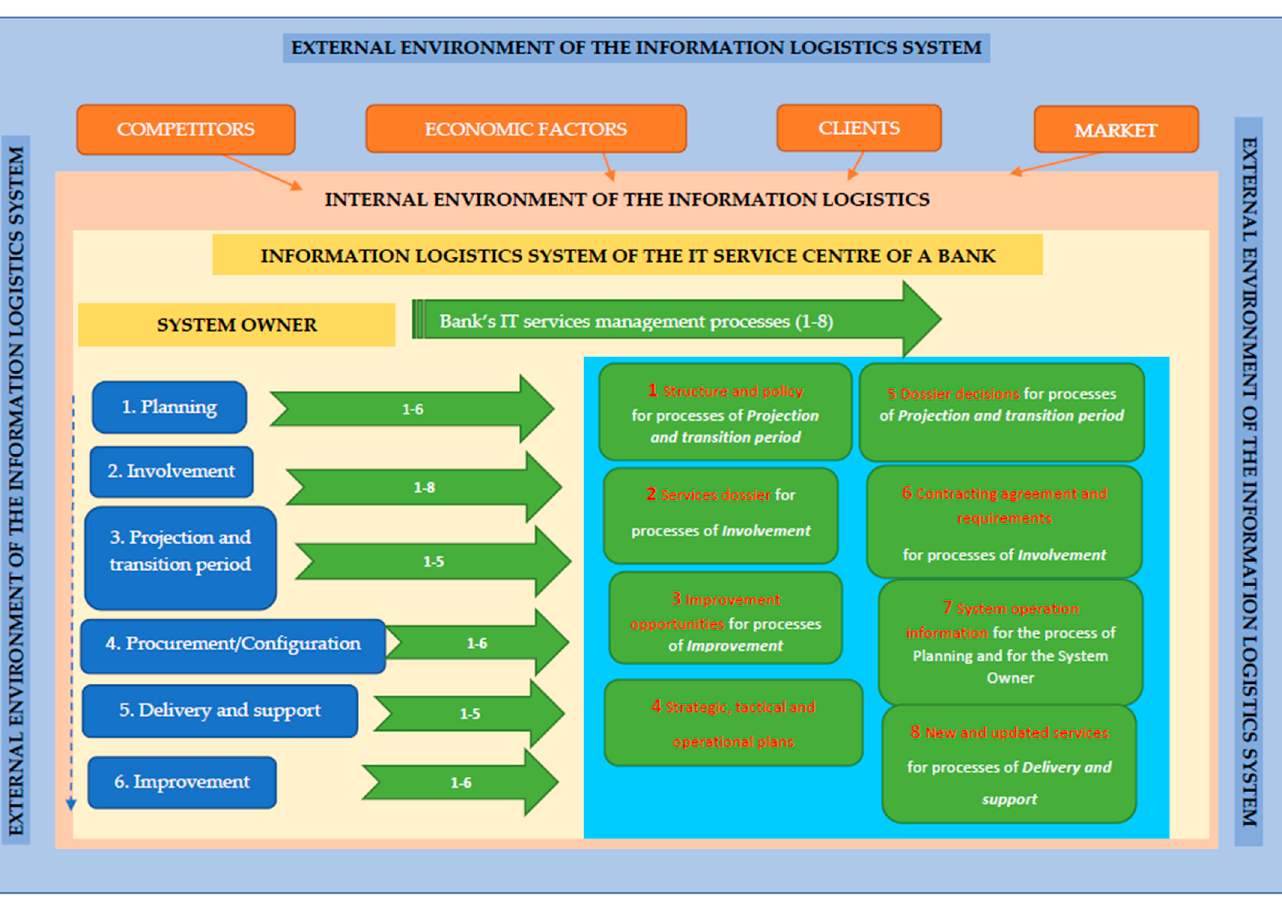
Figure 1. Model for assessing information logistics systems in a bank.